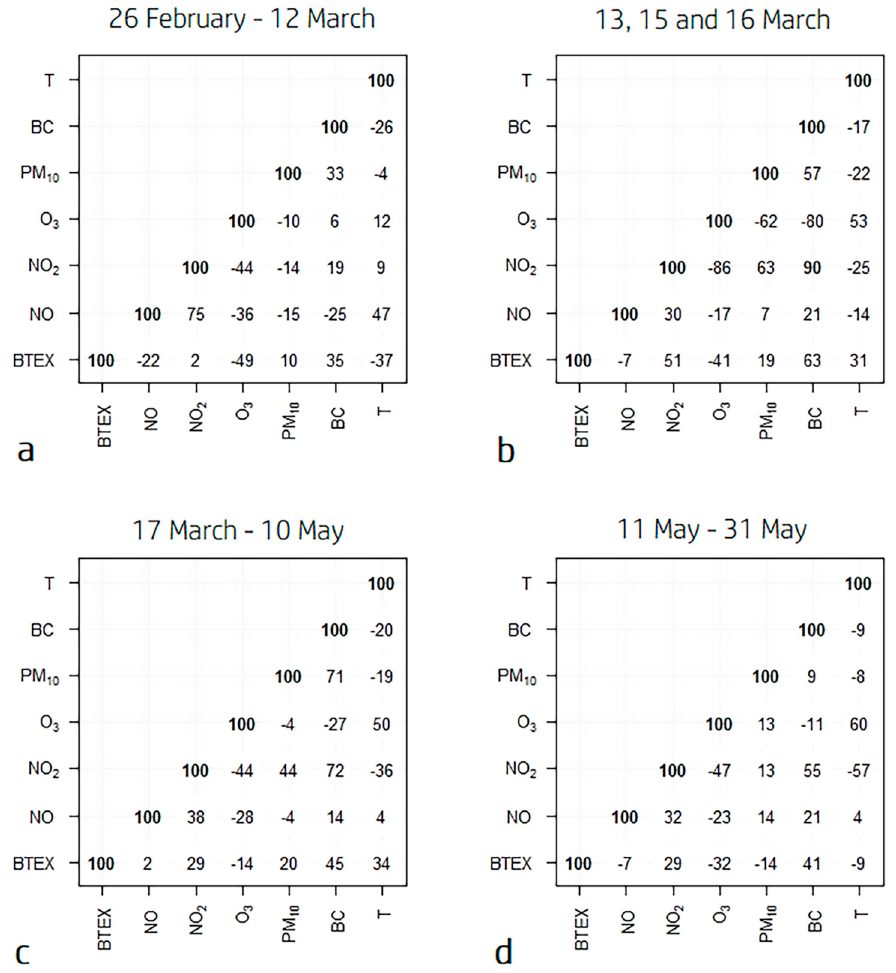
Figure 7. Correlation coefficient in percentage between BTEX, NO, NO 2 , O 3 , PM 10 , BC, and temperature (T) for each period (before, declared, during, and after lockdown). ( a ) before; ( b ) declared; ( c ) during; ( d ) after.